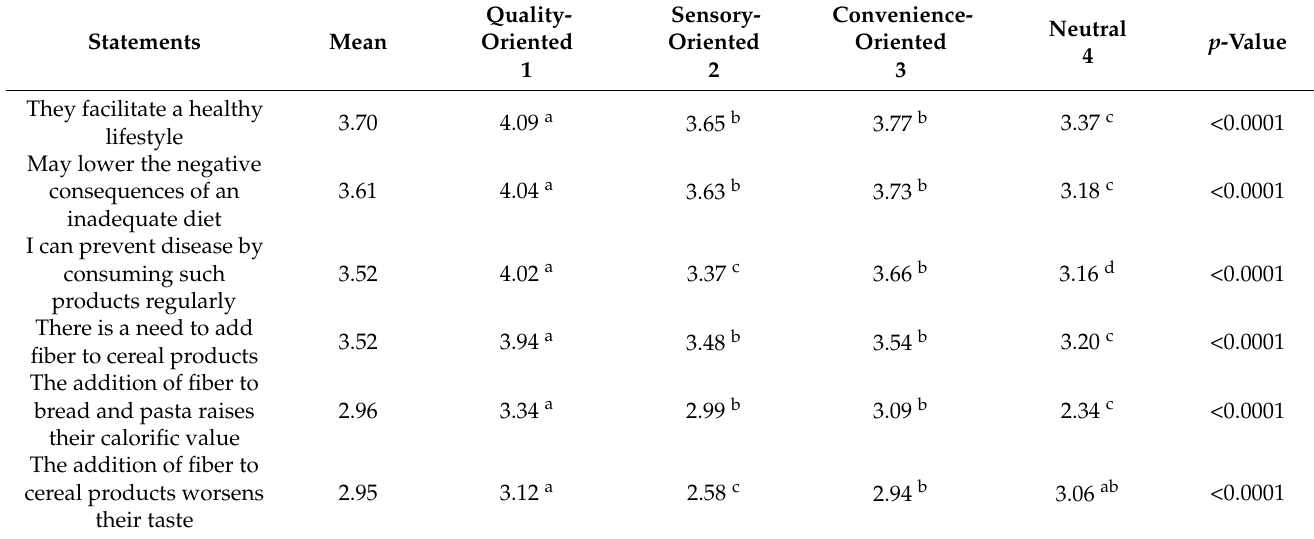
Table 7. Profile of the segments in terms of statements referring to cereal products with added fiber.